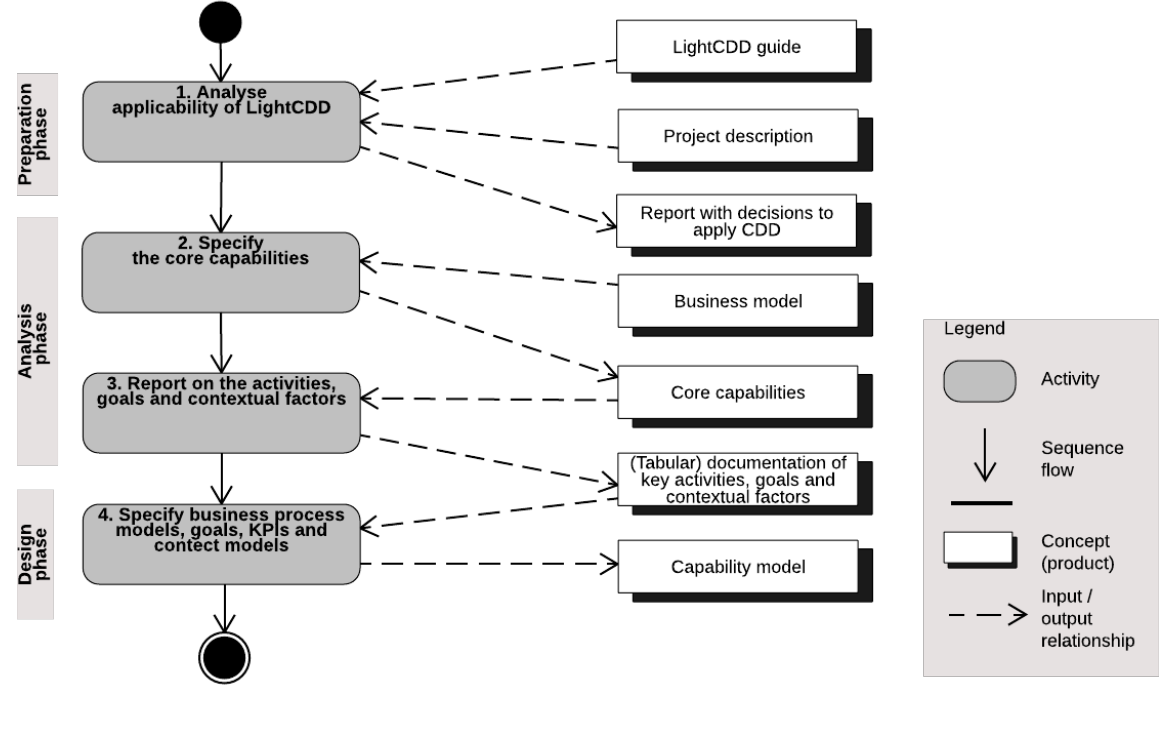
Figure 4. Overview of the